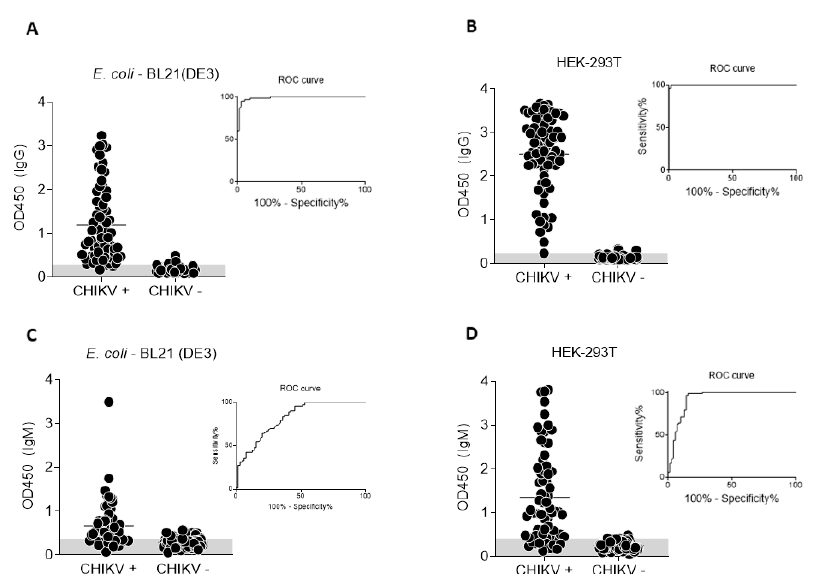
Figure 5. Performance comparison of Indirect ELISAs using either CHIKV-E2 antigen produced in E. coli or HEK-293T cells. Individual CHIKV-negative or -positive sera samples from a characterized sera bank were used to evaluate Indirect ELISAs employing antigens produced in prokaryotic ( A , C ) or eukaryotic cells ( B , D ). Each dot represents an individual serum sample. The ROC curve and observed specificity for the tests are shown as insets on each panel.